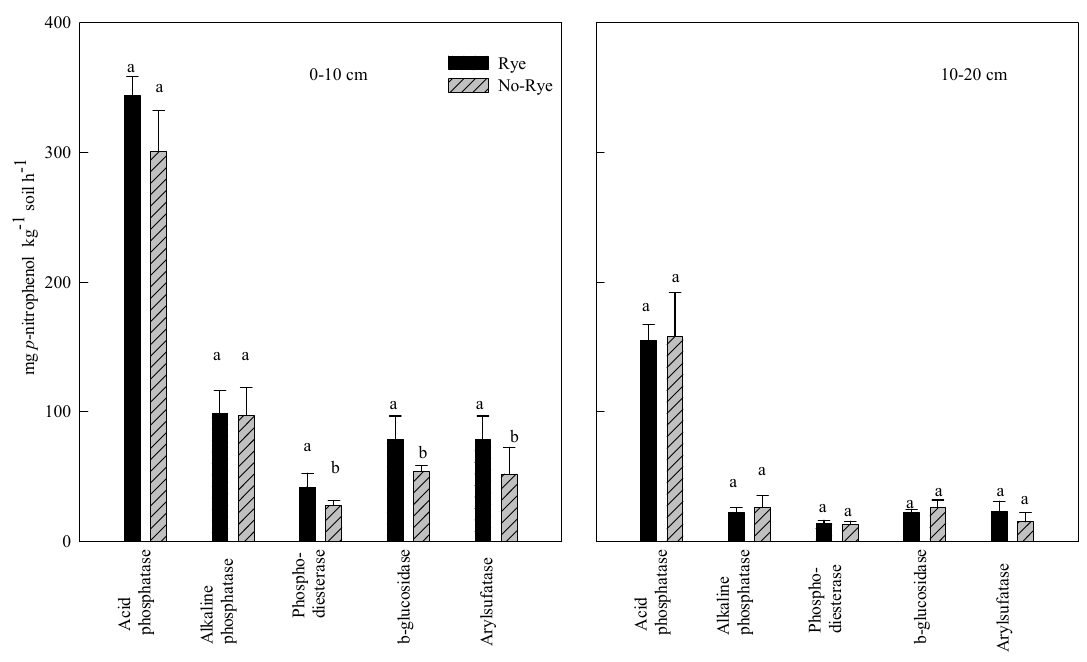
Figure 2. Effect of cover crop (rye) on selected enzyme activities at two soil sampling depths. The bars with different letters within enzyme activity are significantly different ( P < 0.05).